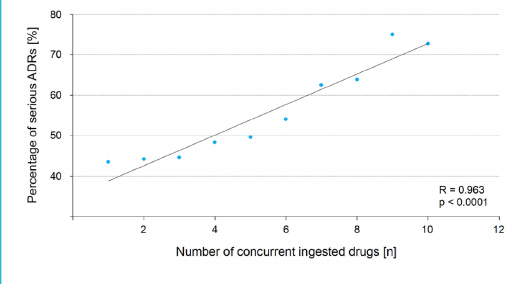
Figure 2: Linear correlation between number of concurrent ingest- ed medications and rate of serious ADRs